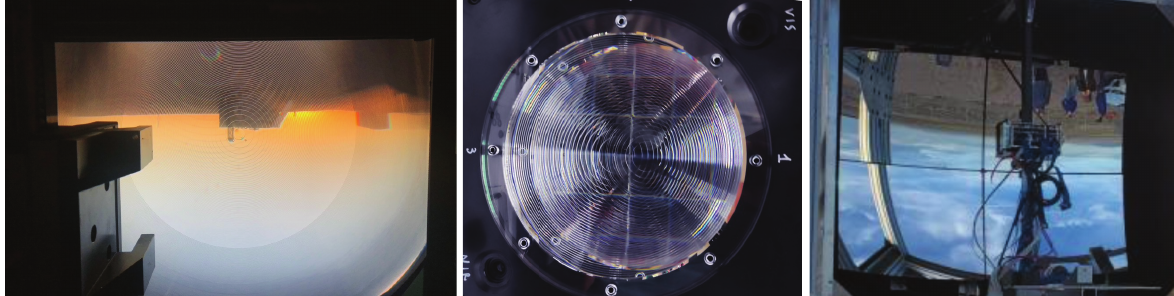
Figure 2. JEM-EUSO optics. Left: view through the EUSO-TA refractive Fresnel optics system. Center: front view of the MINI- EUSO Fresnel lens system. Right: side view of the EUSO-SPB2 mirrors.